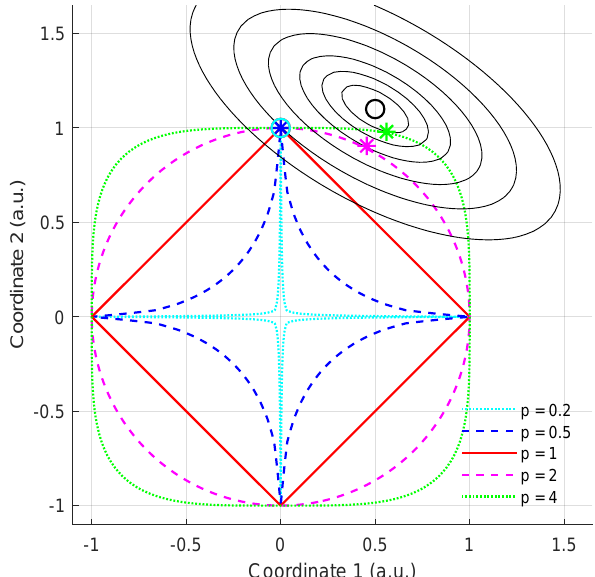
Figure 1. Minimisation of a quadratic function under different L p norm inequality constraints (detailed in the text